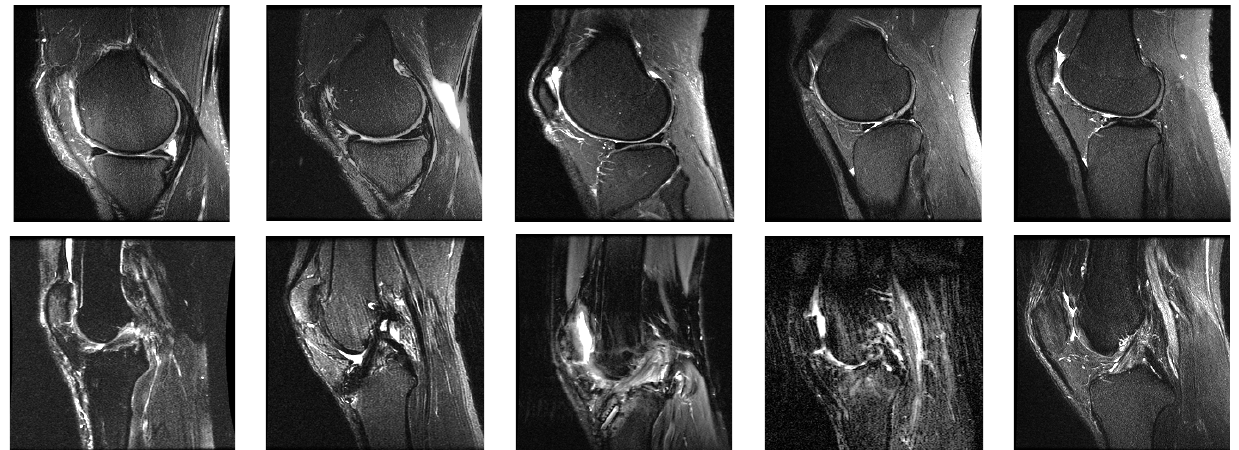
Figure 3. Sample images from the MRNet database.